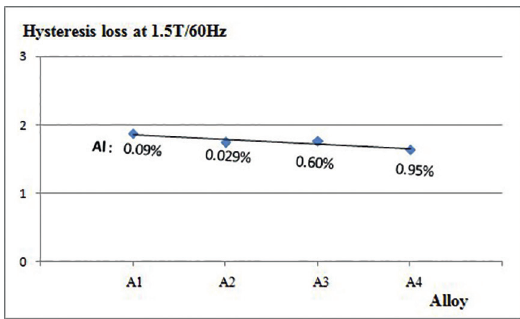
Figure 7: Variation of hysteresis loss as function Al content.